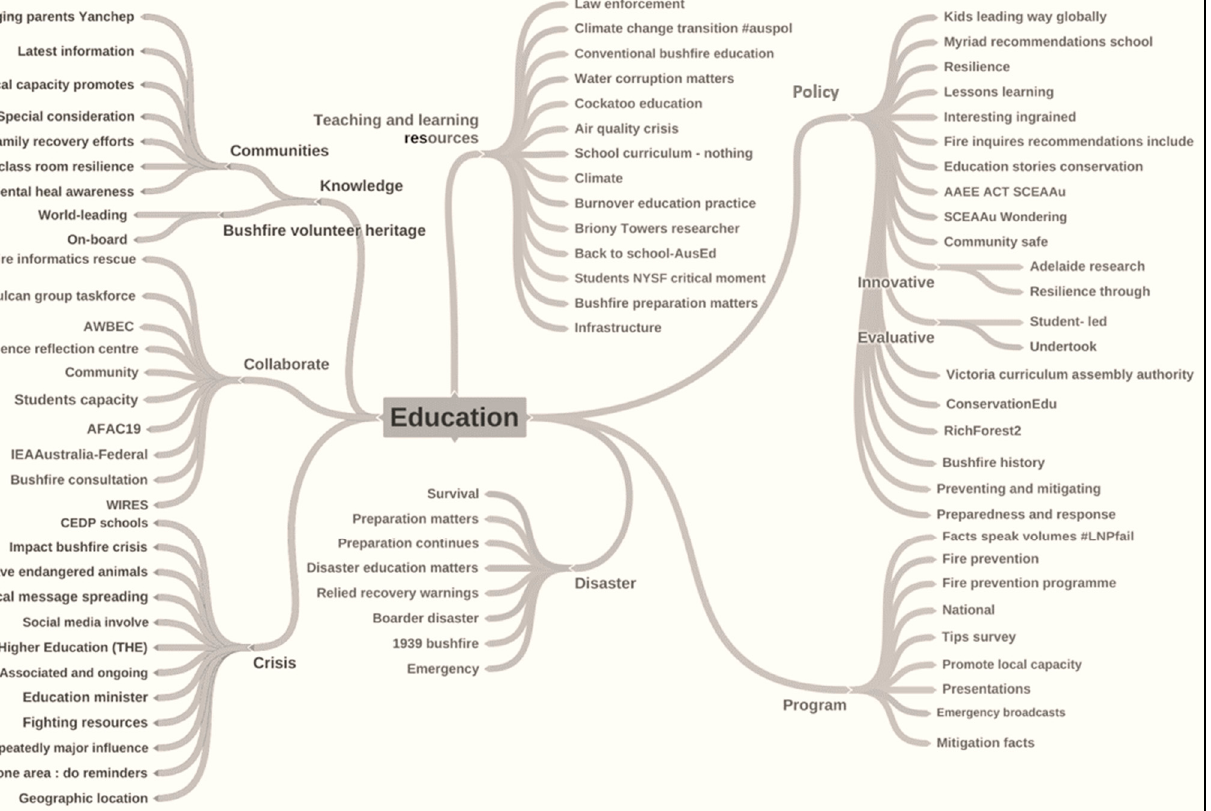
Figure 5. Word-tree diagram.